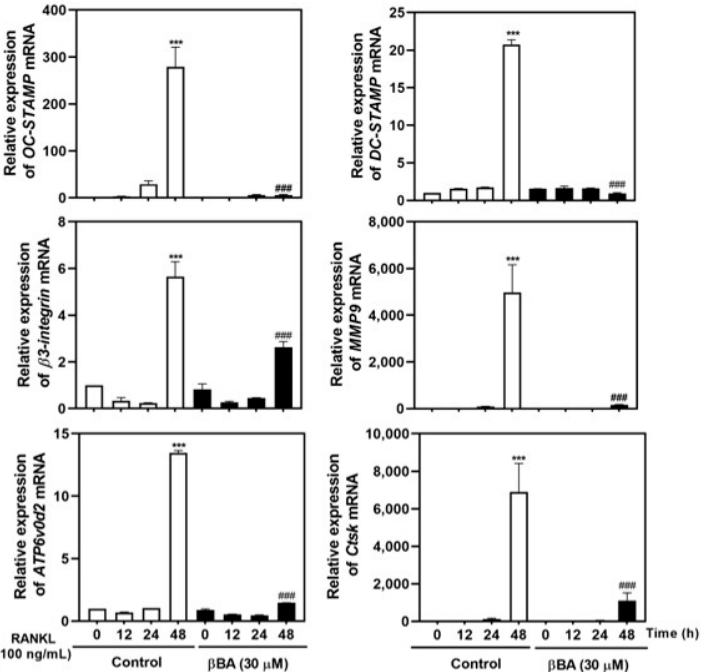
Figure 5. β -boswellic acid ( β BA) inhibits RANKL-induced mRNA expression of OC-STAMP , DC- STAMP , β 3-integrin , MMP9 , ATP6v0d2 , and CtsK . Mouse bone marrow-derived macrophages (BMMs) were incubated with M-CSF (30 ng/mL) and RANKL (100 ng/mL) in the presence or absence of β BA (30 µ M) for the indicated time. Total RNA was isolated from cells using TRIzol reagent, and the mRNA expression of OC-STAMP , DC-STAMP , β 3-integrin , MMP9 , ATP6v0d2 , and CtsK was analyzed by real-time RT-PCR. Data represent means ± SD (n = 4). *** p < 0.001 vs. control at 0 h; ### p < 0.001 as compared with DMSO control at the indicated time.